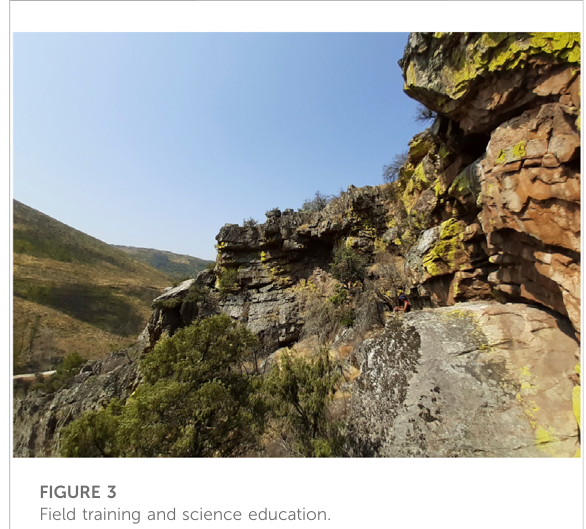
FIGURE 3 Field training and science